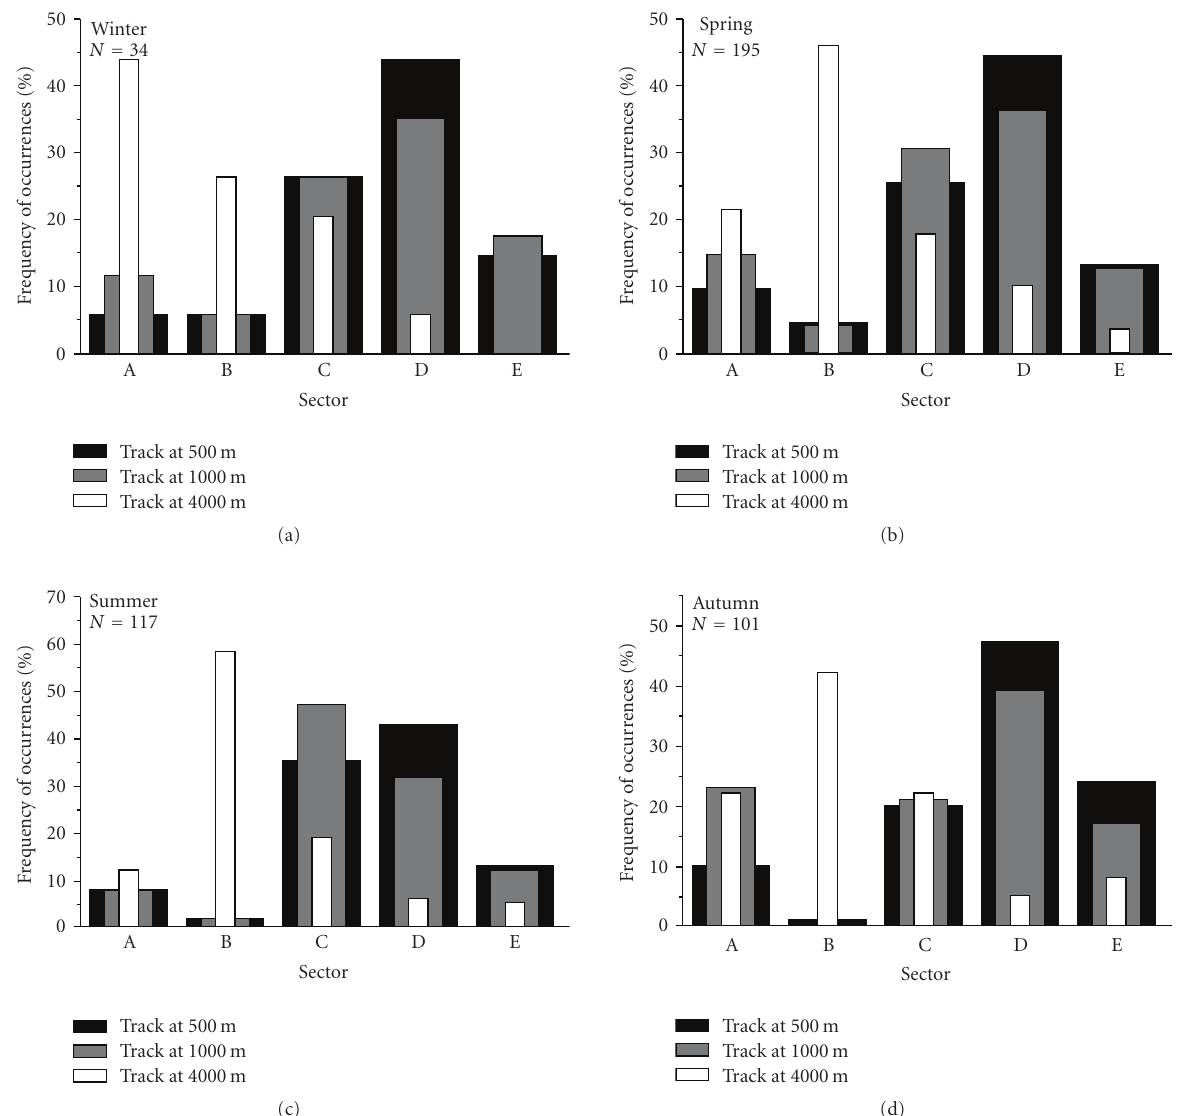
Figure 6: Seasonal frequency (%) distribution of the air-mass trajectories at three atmospheric levels over GAA for the UI aerosol type. The number of data, N, in each season is also